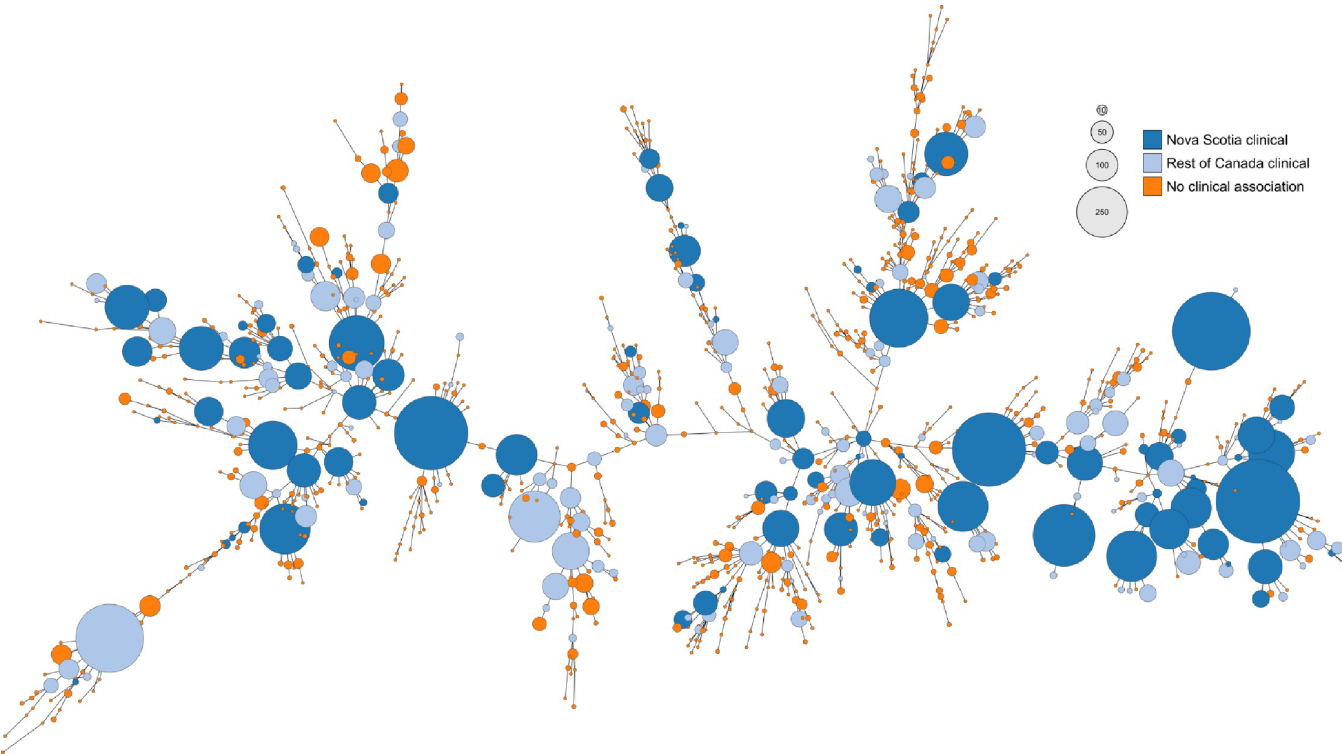
Fig 3. Distribution of human clinical association on the population structure of chicken CGF subtypes observed in Canada. A minimum spanning tree of all CGF subtypes found in the C3GFdb that have been recovered from chicken and their association with human clinical isolates. Represented are chicken subtypes observed in clinical cases from both Canada and this study (dark blue), in Canada but not in this study (light blue), and chicken subtypes not associated with a clinical case (orange). The size of each node is representative of the aggregate number of isolates in this study and the C3GFdb.